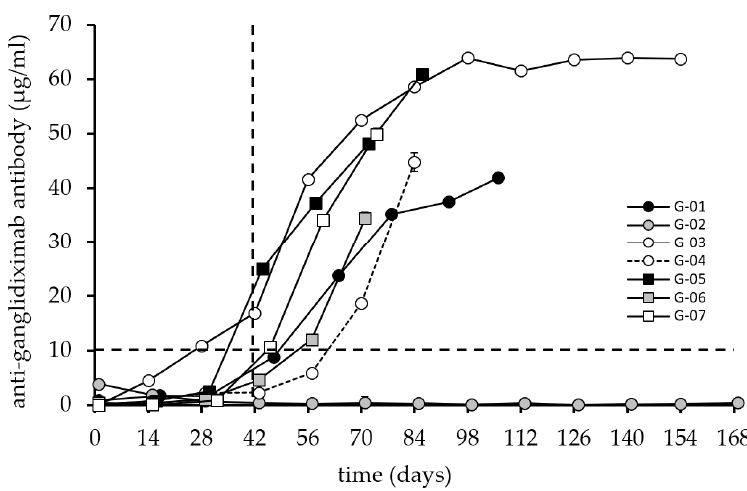
Figure 3. Induction of an anti-ganglidiximab humoral response after vaccination with ganglidiomab. The anti-ganglidiximab response serum levels were analyzed by ELISA following the procedure described previously. The graphs indicate the mean value for each patient at each visit. The standard deviation (error bar) is too small to display and is covered by the size of the symbol. The dashed lines indicate the 10 µg/mL level (horizontal) and the 42-day time point after three vaccinations (vertical) for illustration purposes.